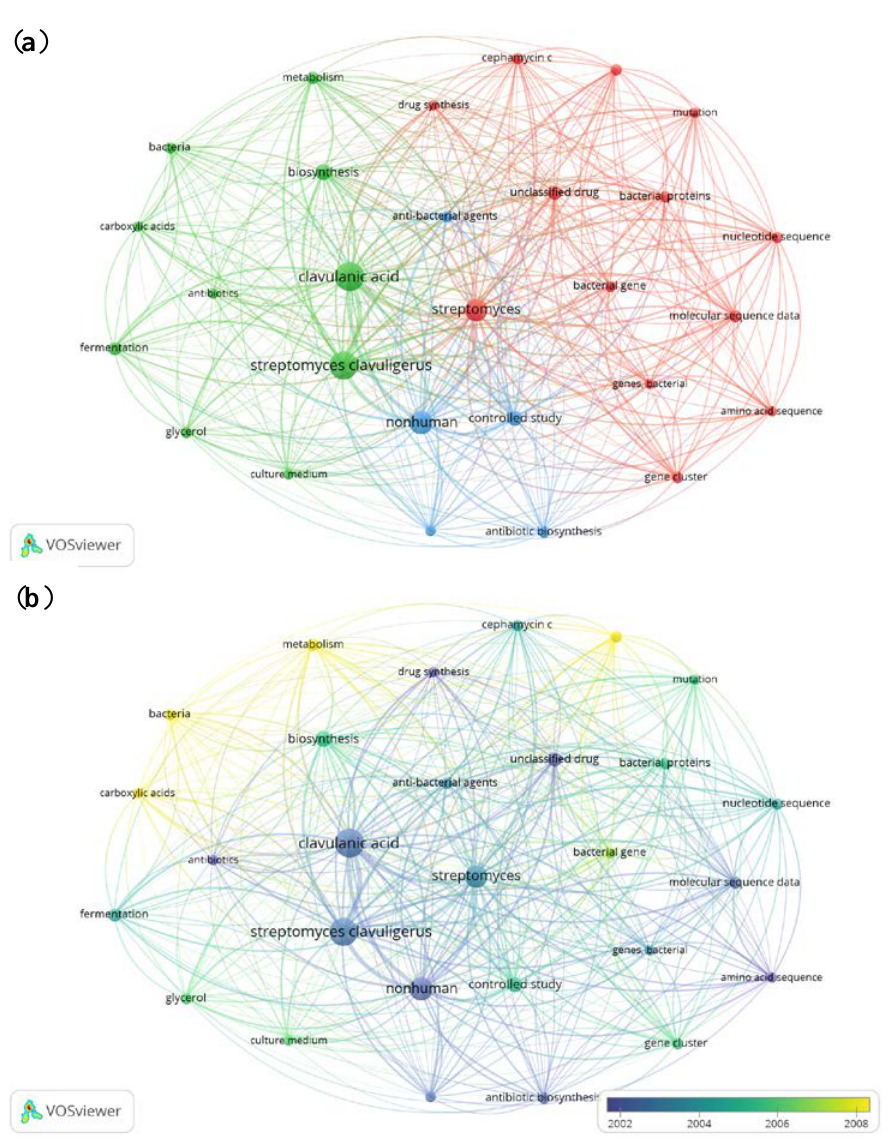
Figure 6. Network of clavulanic acid studies by Streptomyces clavuligerus in the period of 1975–2017. ( a ) Research-topic map for publications about clavulanic acid production by Streptomyces clavuligerus . ( b ) Research-topic map with time overlay (2002–2008) for studies on clavulanic acid production by Streptomyces clavuligerus .